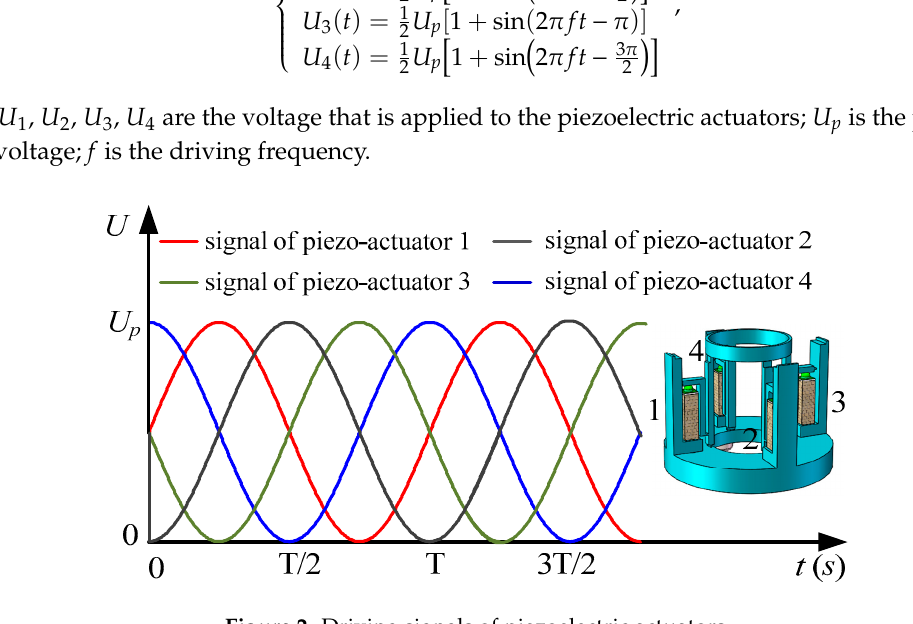
Figure 2. Driving signals of piezoelectric actuators.